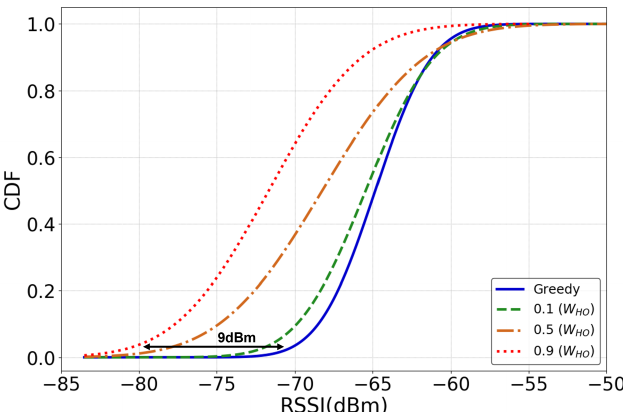
Figure 8. RSSI at the UAV during a trajectory under greedy and UHD methods with 0.1, 0.5, and 0.9 W HO